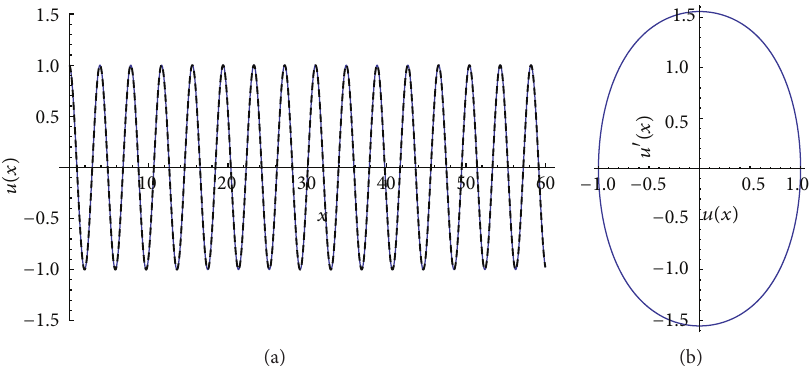
Figure 3: (a) Plots of displacement of 𝑢 versus time. (b) Phase plane diagram of Example 3: solid line the multistep RKHS method and dashed line RK